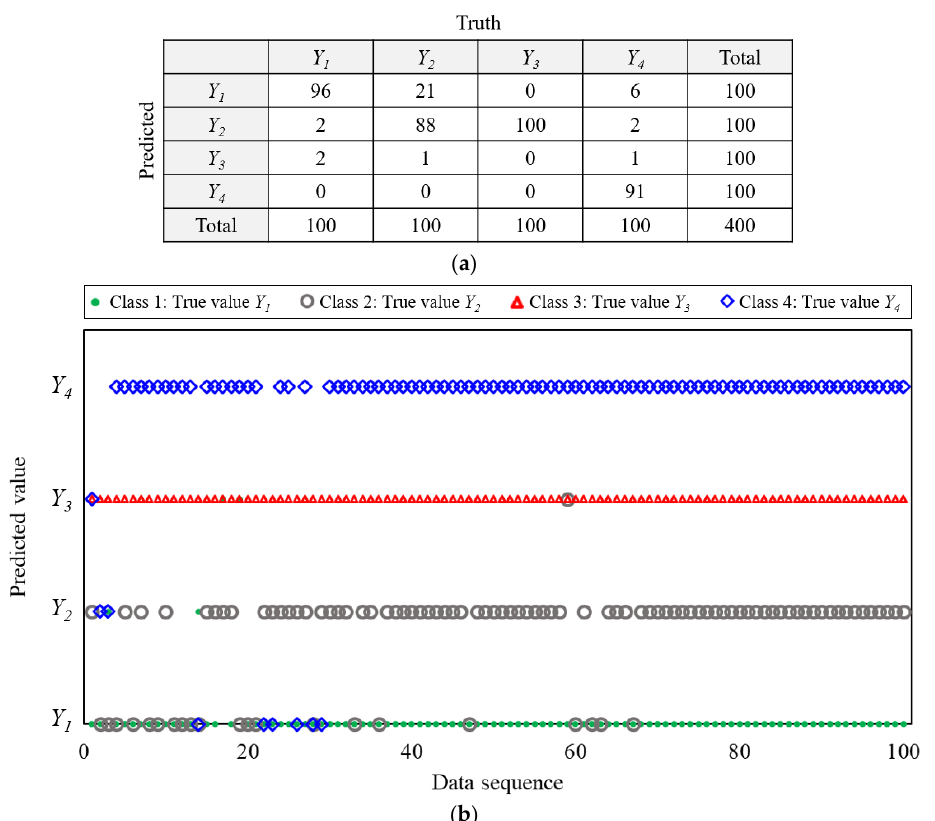
Figure 12. Verification results: ( a ) confusion matrix; ( b ) prediction result according to data sequence.